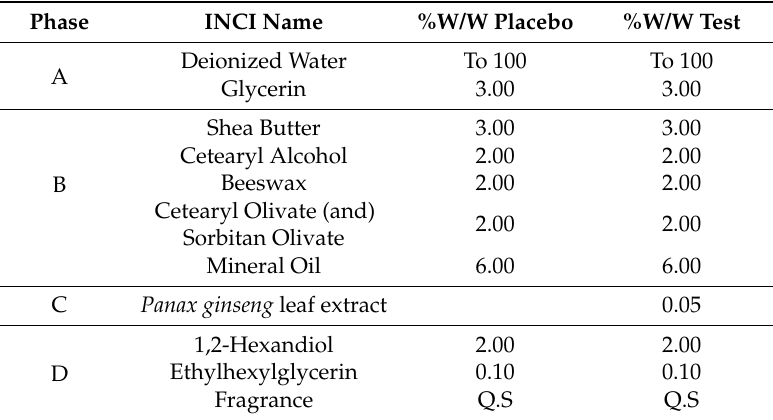
Table 1. Formulation of PGLE-containing lotion and placebo